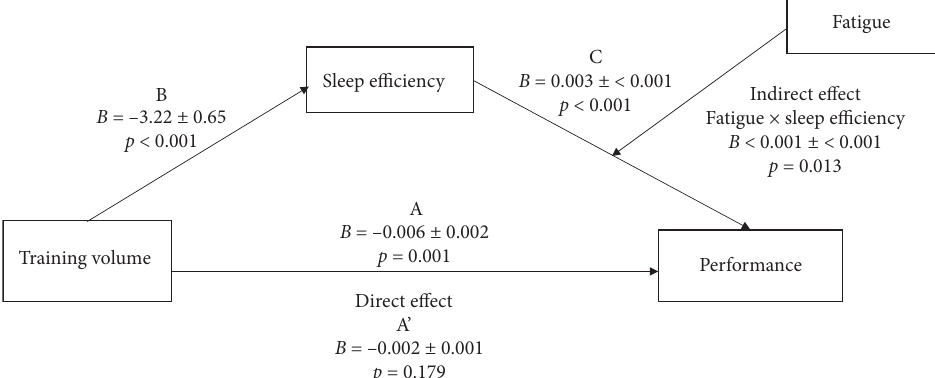
Figure 2: Conceptual model of prior training volume to performance relationship illustrating moderated mediation effects of sleep ef- ficiency x fatigue ( B � unstandardized coefficients ± standard